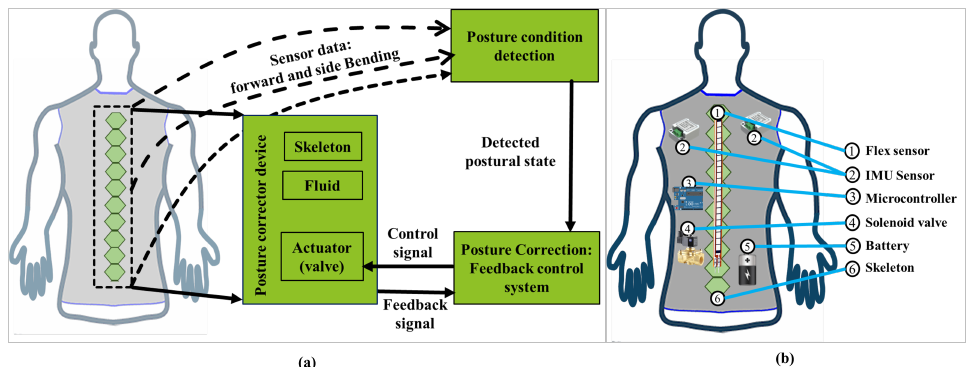
Figure 1. Overview of the proposed posture corrector ( a ) framework and ( b ) component